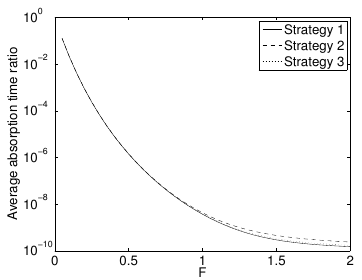
Figure 13: Ratio between values of τ with and without attacker, F ∈ (0 , 2]